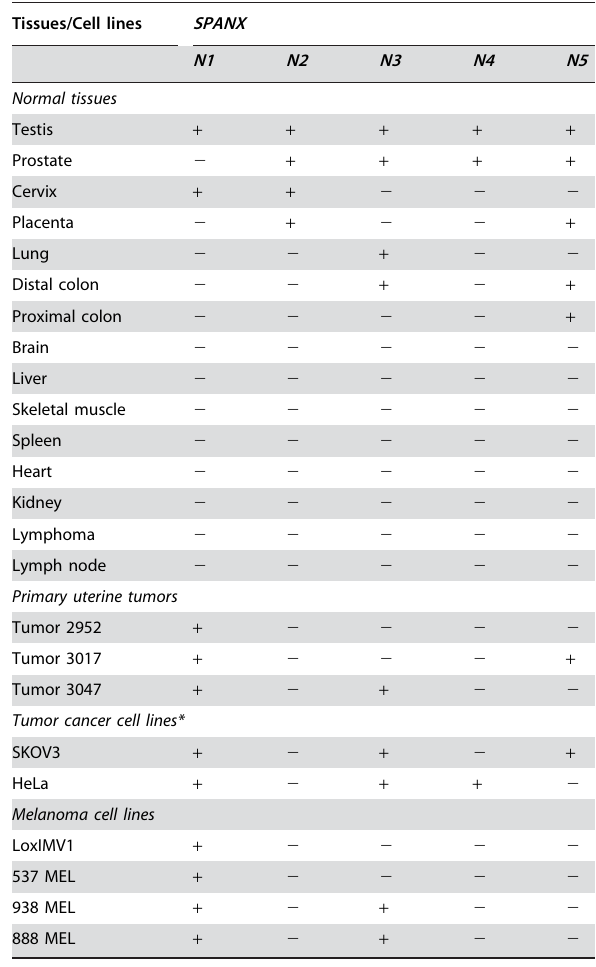
Table 2. RT-PCR analysis of SPANX-N expression in normal and Tissues/Cell lines SPANX